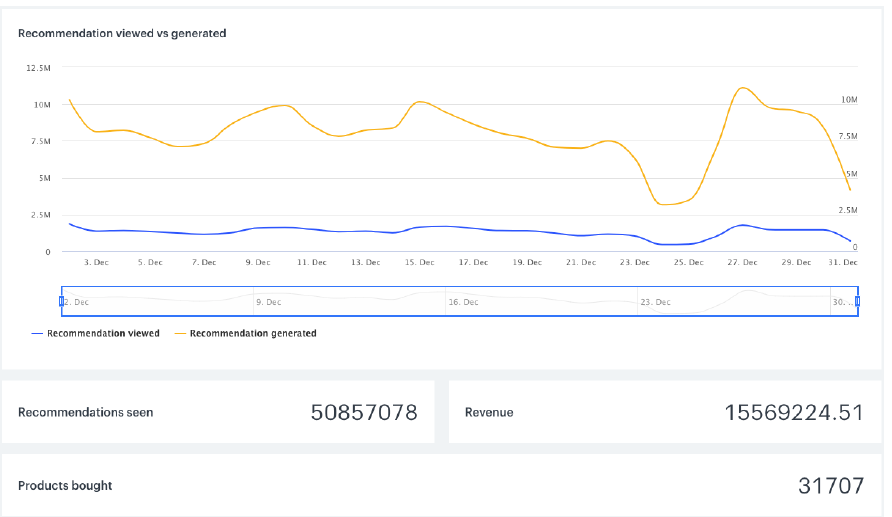
Figure 7. Recommendation analytics plot—viewed and clicked